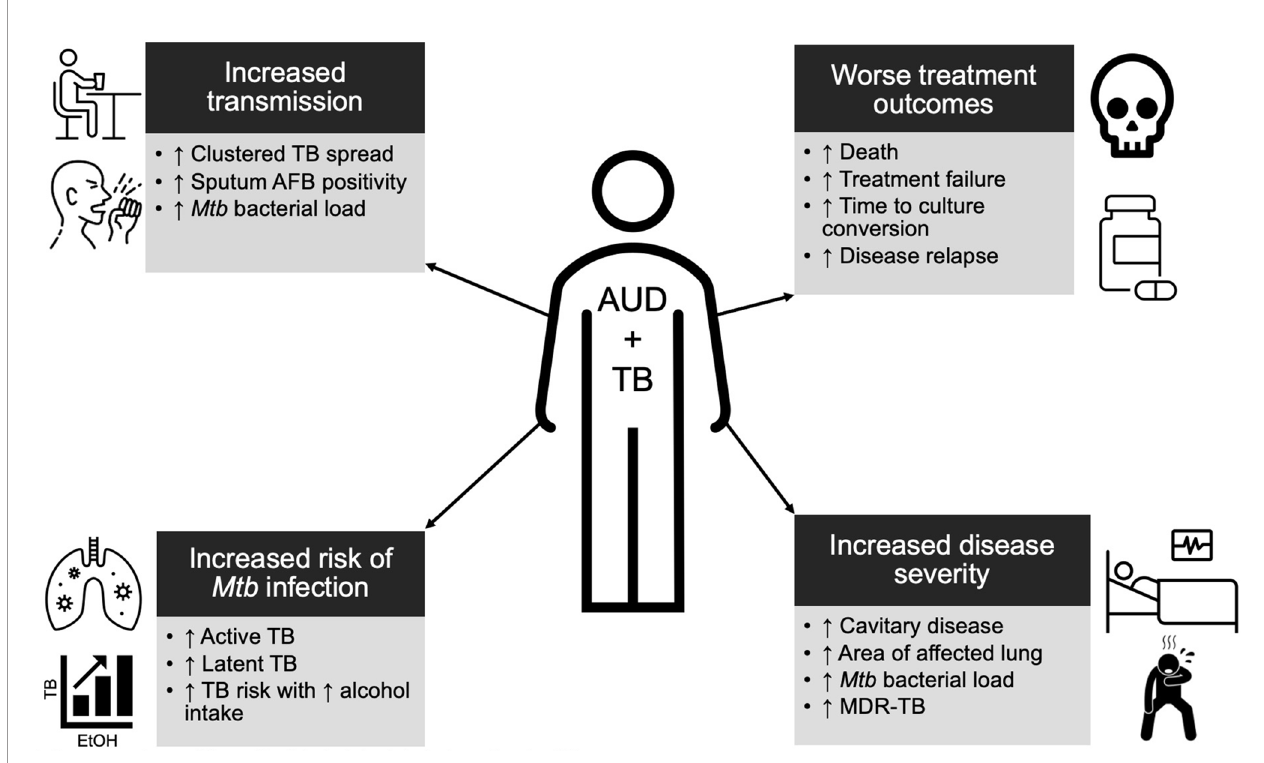
FIGURE 1 | Summary schema of the epidemiologic data of alcohol use disorder (AUD) and tuberculosis (TB). Individuals with AUD are at a higher risk for TB, more infectious, have more severe disease, and are more likely to experience poor outcomes. See main text for further